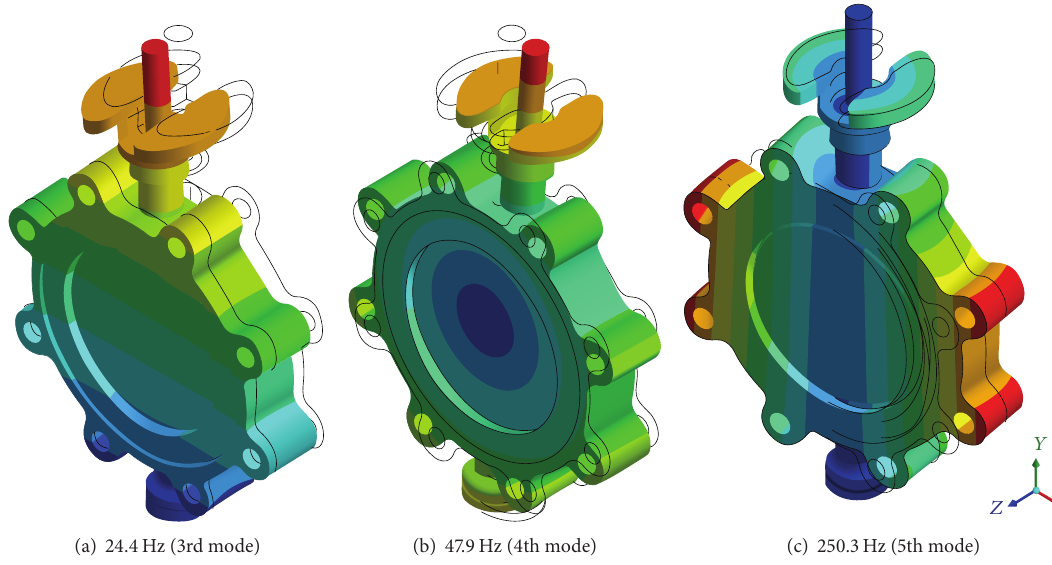
Figure 10: Frequencies at each mode obtained by modal analysis based on dynamic analysis.